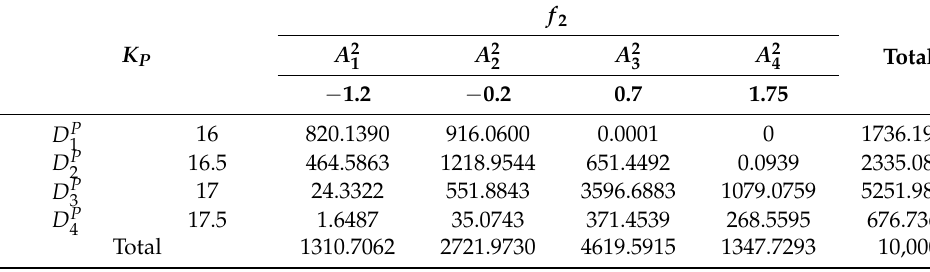
Table 7. The casting results of sample pairs ( f 2 , K P ).